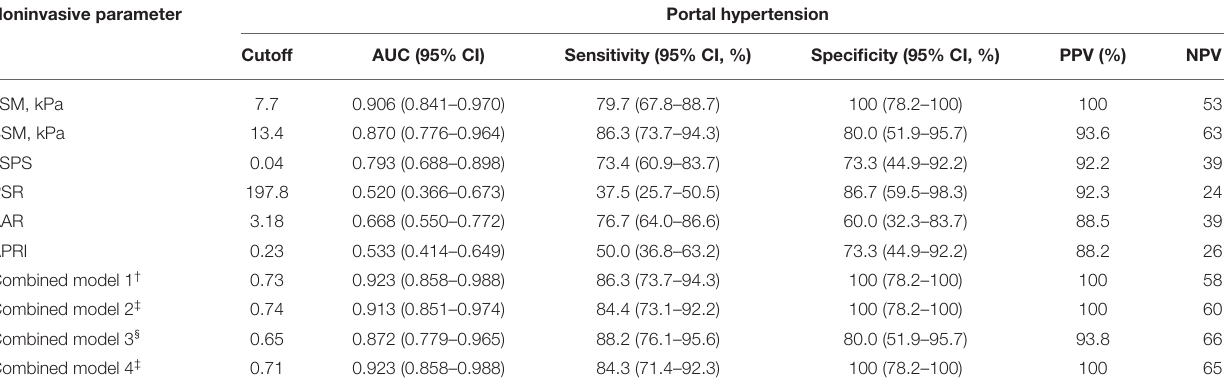
TABLE 3 | Predictive value of noninvasive methods and combined models for assessing portal venous pressure. Noninvasive